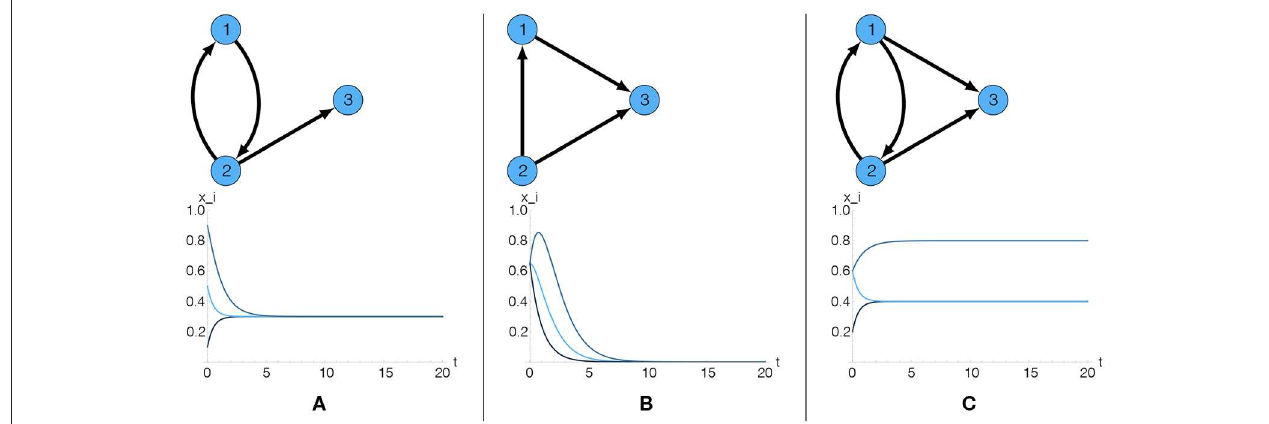
FIGURE 2 | Impact of the adjacency matrix on the reputation R i ( t ) of three agents. Only if cycles exist and agents are connected to these cycles, a non-trivial stationary reputation can be obtained. (A) The presence of one cycle guarantees a non-trivial stationary reputation, identical for all agents. (B) The absence of cycles results in a trivial stationary reputation for all agents. (C) The presence of a cycle guarantees non-trivial stationary reputations. Furthermore, two different stationary values appear when agent 3 has 2 incoming links to boost its reputation.